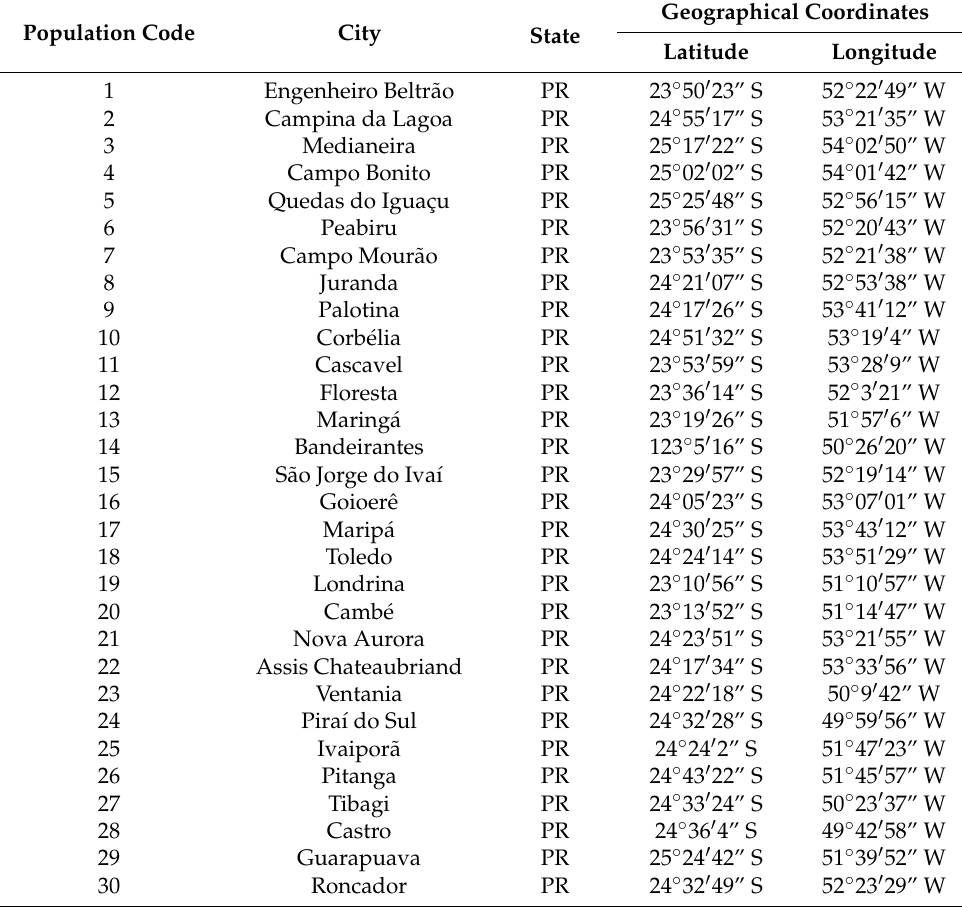
Table 3. Identification of populations and sampling sites for Erigeron sumatrensis seeds in Maring á , PR,